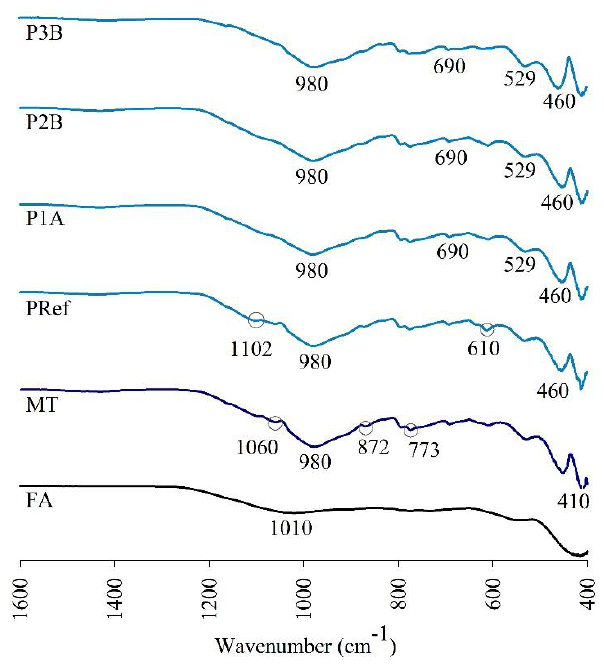
Figure 9. IR spectra of the original materials and most effective pastes. Table 4. Summary of the sulphur-related peaks presented in Error! Reference source not found. .